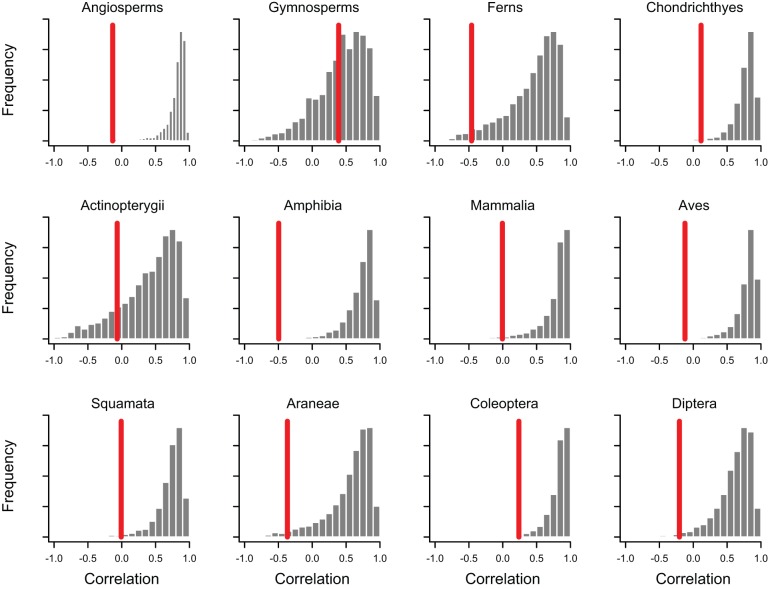
Distributions of rank-order correlations between clade age and species
richness predicted under MEDUSA model of rate variation for 12 major
taxonomic groups.Vertical red lines show the observed correlation for each group. Observed
correlations are significantly lower than the corresponding model-predicted
value for 10 of the 12 groups. The high variance of the MEDUSA-predicted
distributions for gymnosperms and actinopterygiians is largely explained by
the small number of clades (N = 12)
available for those groups (Figure S5).